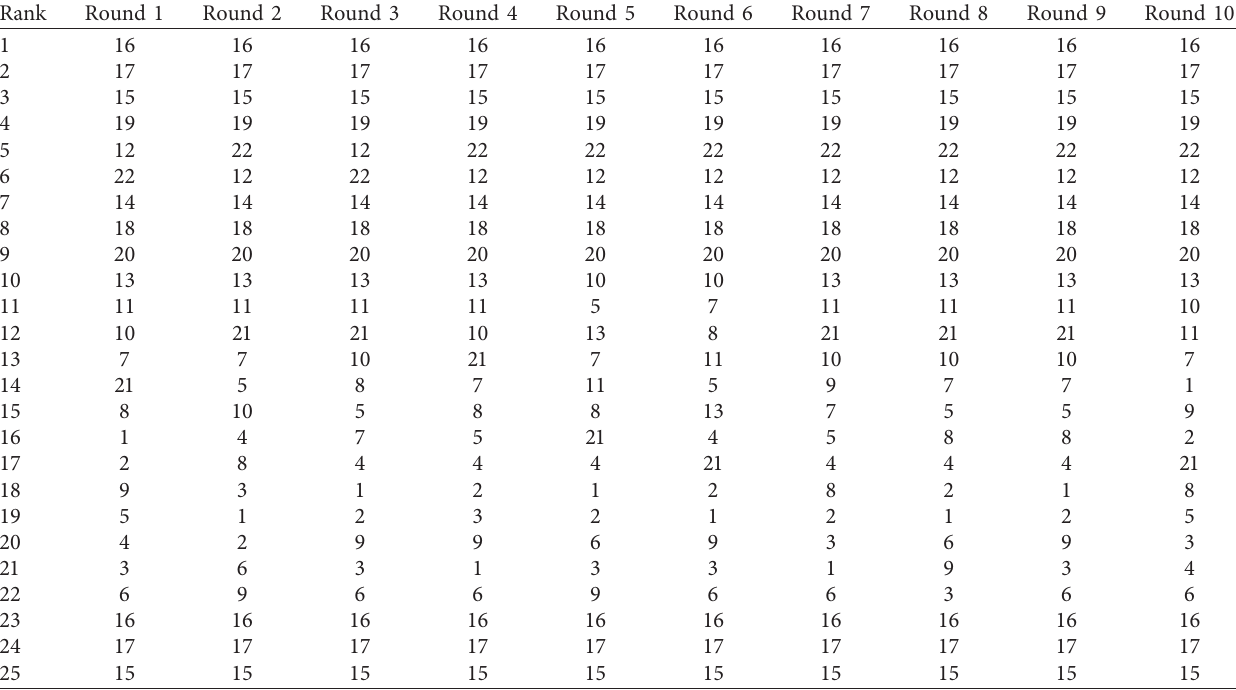
Table 7: Rank of the indexes for features in 10